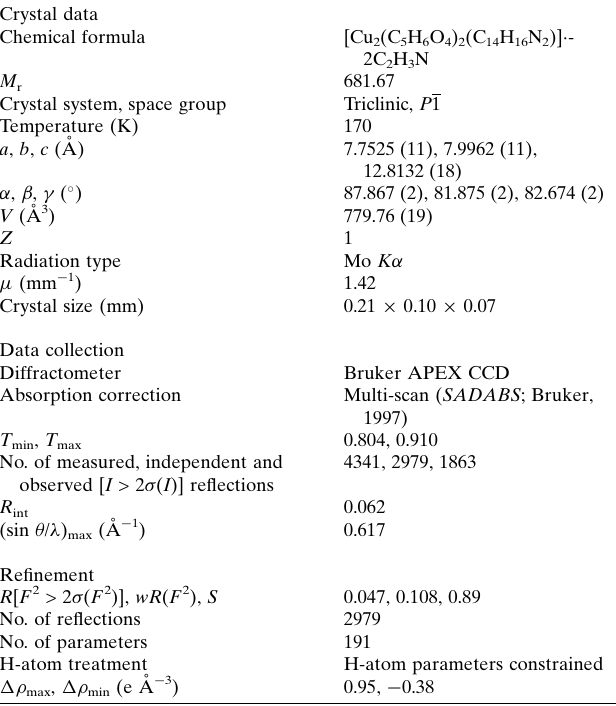
Table 1 Experimental details.